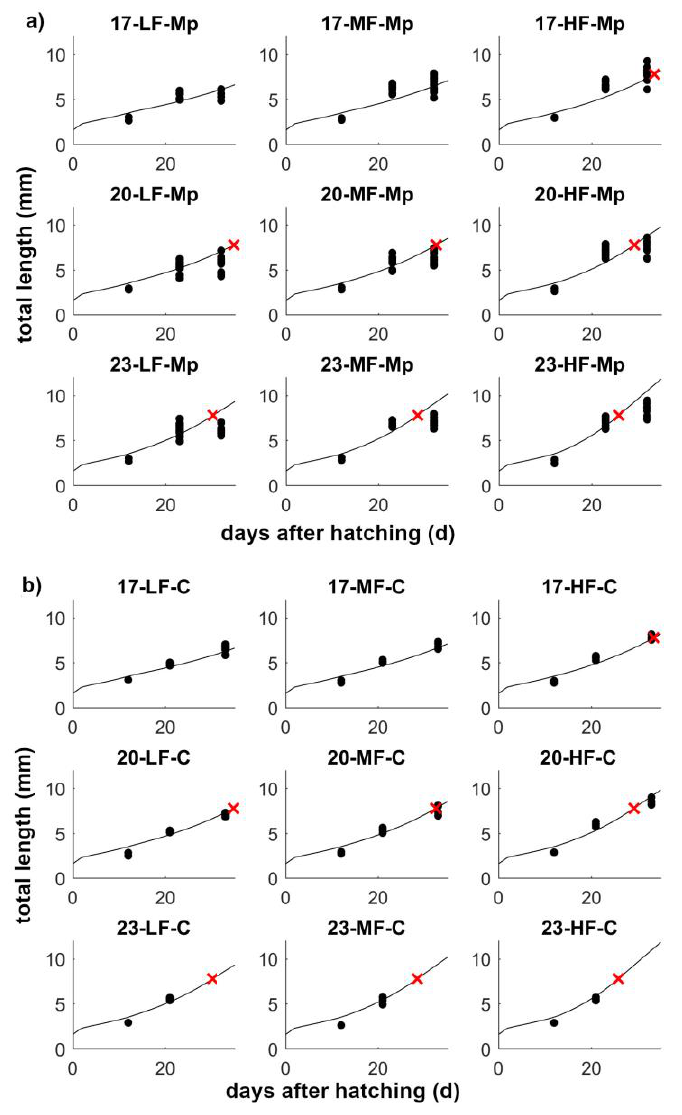
Figure 2. Model validation for S. senegalensis . Larvae length (points) and DEB model larval growth predictions (lines) for S. senegalensis larvae reared at three food availabilities (HighFood, HF; Medi- umFood, MF and LowFood, LF) and three constant temperatures (17 °C, 20 °C, and 23 °C). ( a ) Mp- microplates (individual fish); ( b ) C — containers. Red X in the panels (where present) marks the end of metamorphosis as predicted by the model. Experimental conditions were modeled as follows: temperature for incubation and first 12 days of rearing: 17 °C, afterward: 17 °C (top row), 20 °C (middle row), or 23 °C (bottom row). Temperature switches in the experimental simulations are linked to time. Size at birth will depend on the scaled food availability ( f ) experienced by the mother ( f = 1), while subsequent growth will depend on experimental conditions (food and temperature) experienced by the larvae. Experimental f for larvae switches on day 12 from the initial f EXP = 0.6 to treatment-specific: f LF = 0.4, f MF = 0.45, f HF = 0.55. All f values were adjusted manually. Physiological parameters were kept fixed at values listed in Table 2.